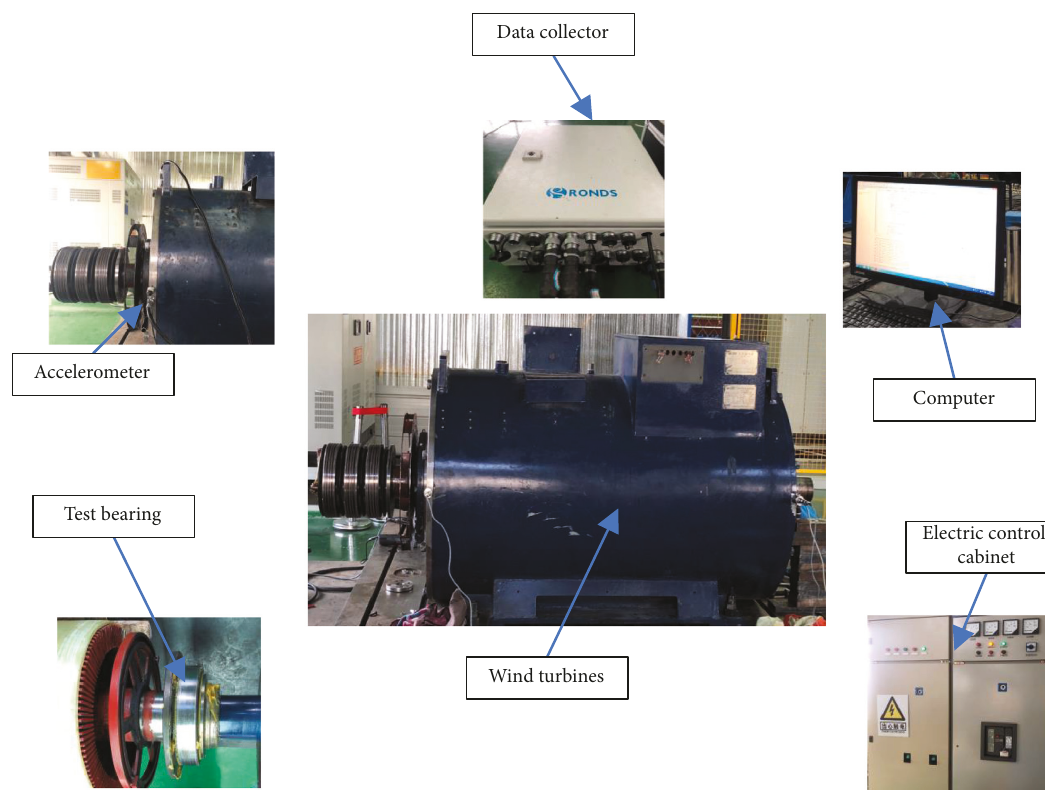
Figure 17: Wind turbine experimental platform.